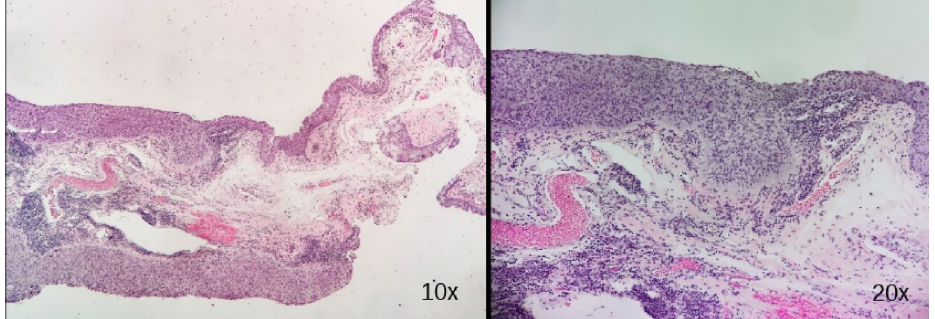
Figure 2: CIN was confirmed by histopathological study with free margins; normal conjunctival epithelium at the top of the biopsy and dysplastic cells at the bottom in image 10x; dysplastic epithelium with high mitosis index in image 20x